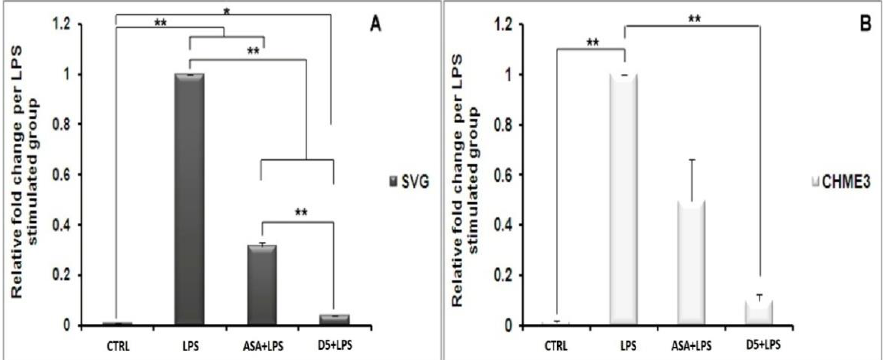
Figure 6. Regulatory effects of D5 on IKK- β mRNA expression in LPS-Stimulated astrocyte (SVG ) and microglia (CHME3 ) cell lines. ( A ) Astrocytic glial (SVG) and ( B ) microglial (CHME3) cells were treated with D5 and ASA (0.71 µM and 52.73 µM, respectively) for 2 h, and then incubated with LPS (100 ng/mL) for 24 h.Total cellular mRNA was isolated and the normalization of the optical density of individual IKK- β mRNA was performed using the corresponding levels of GAPDH mRNA. Data are presented as the number of fold changes based on the level of IKK- β mRNA expression in the positive control groups of both cell lines. Data are presented as the mean ± S.D. of four samples in one independent experiment. The data were replicated in three repeated independent